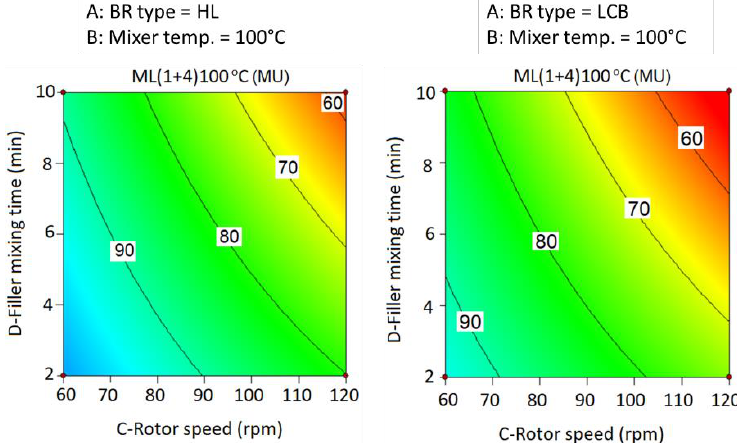
Figure 4 . The effect of the rotor speed and filler mixing time on MV in rubber compounds containing HL-BR and LCB-BR .